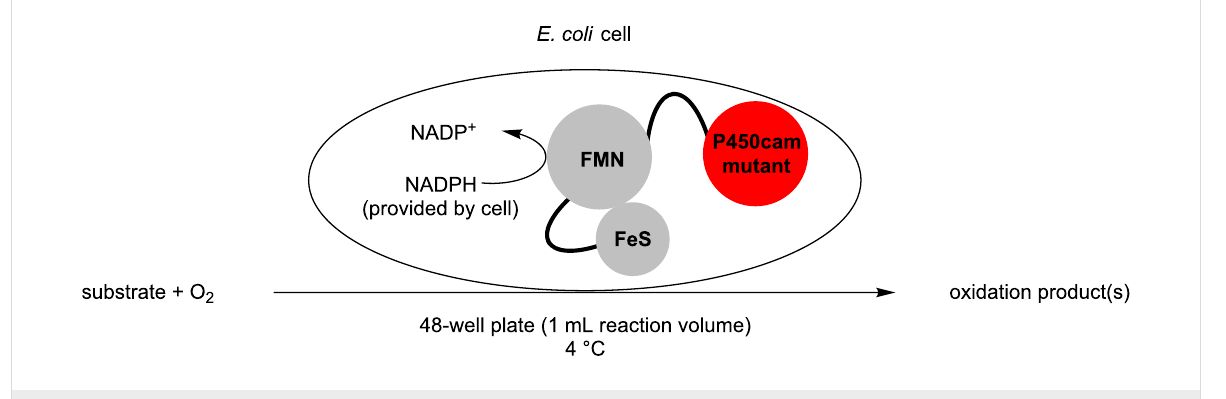
Figure 1: Oxidation reactions with P450cam-RhFRed mutants.